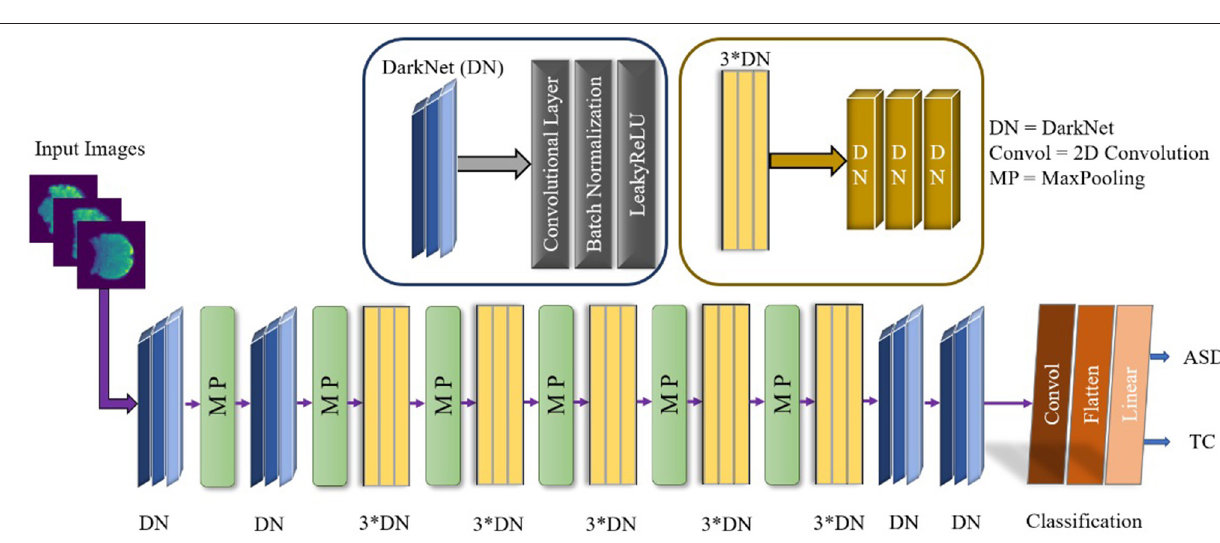
FIGURE 2 | The overview of the 3D fMRI data processing for both ASD and TC.